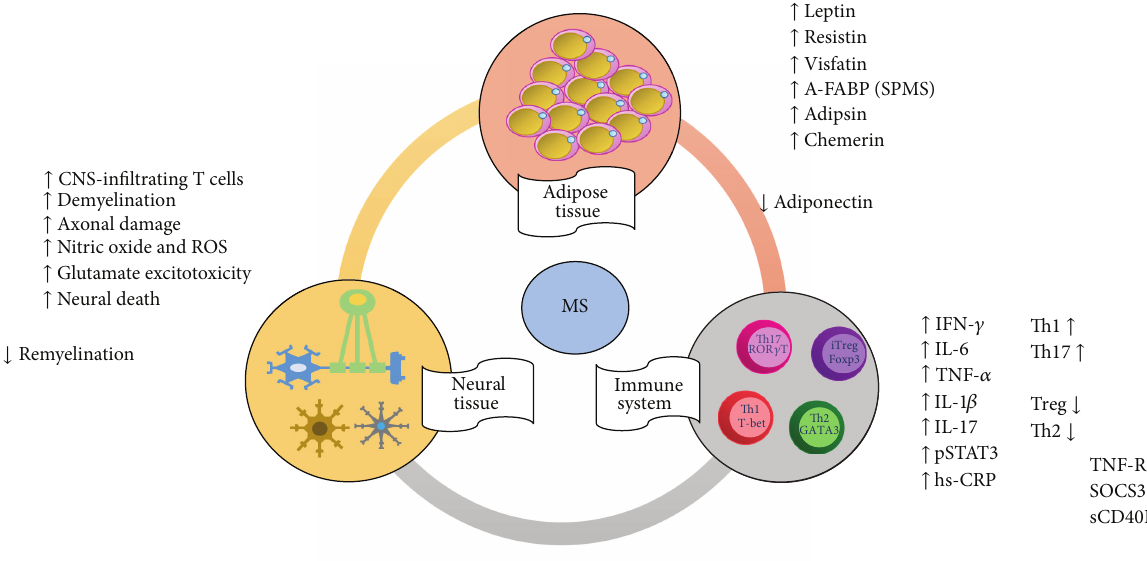
Figure 2: Cross talk among immune, neural, and adipose tissues. Adipocytes release leptin, resistin, and visfatin, which induce a low-grade inflammatorystateinpatientswithmultiplesclerosis(MS)withobesity.TcellsmigrateintotheCentralNervousSystem(CNS),withTh1/Th17 cell release of proinflammatory cytokines, which promote the inflammatory status, and Th2/Treg release of anti-inflammatory cytokines, which contributes to modulating the severity of multiple sclerosis (MS). Neurons and oligodendrocytes are those mainly affected in MS. Axons are demyelinated by cell- and molecular-mediated mechanisms. Antigen presentation between microglia and CNS-infiltrating T cells induces a proinflammatory positive feedback loop. Astrocytes costimulate CNS-infiltrating T cells through CD24